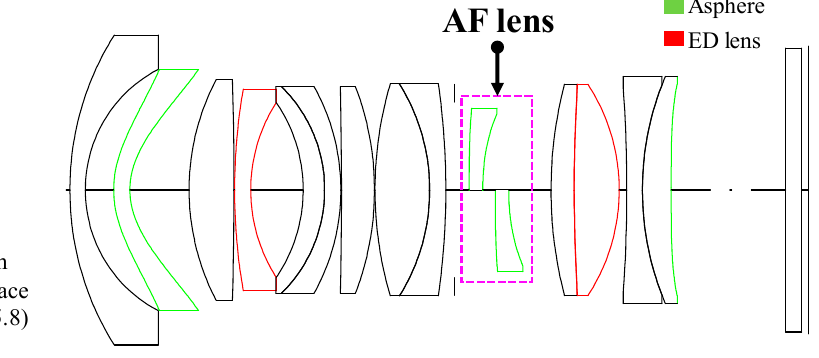
Figure 8. Diagram of the final design.